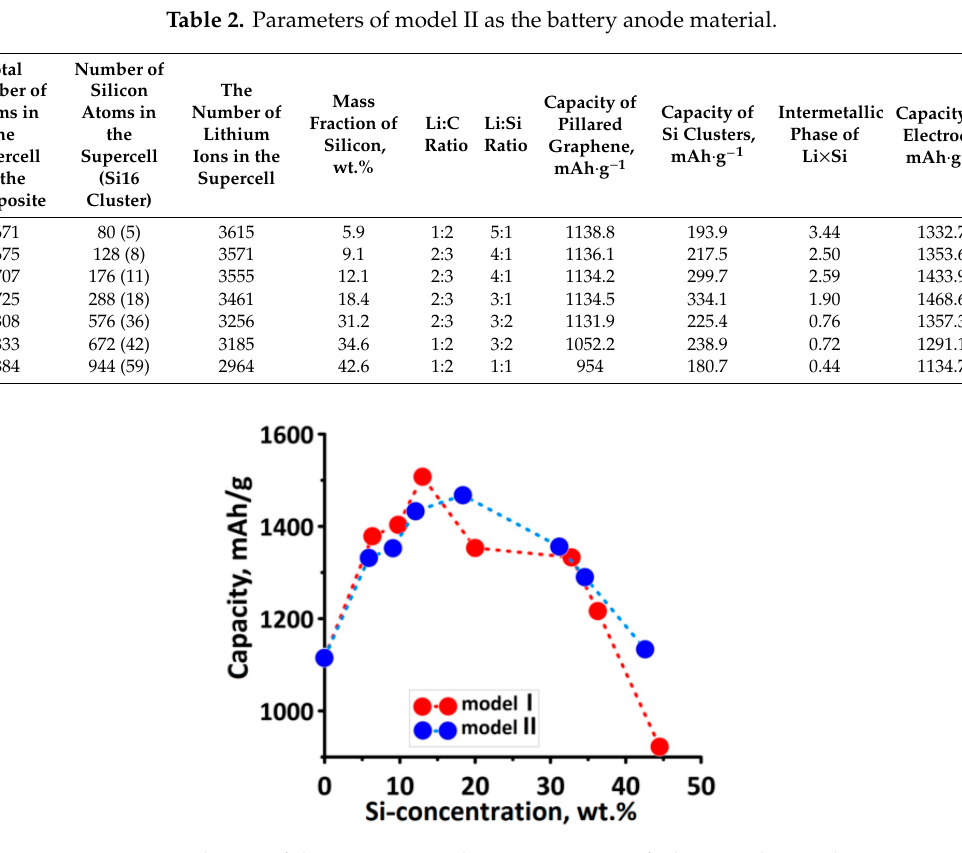
Figure 4. Change of the capacity vs. the concentration of silicon in the